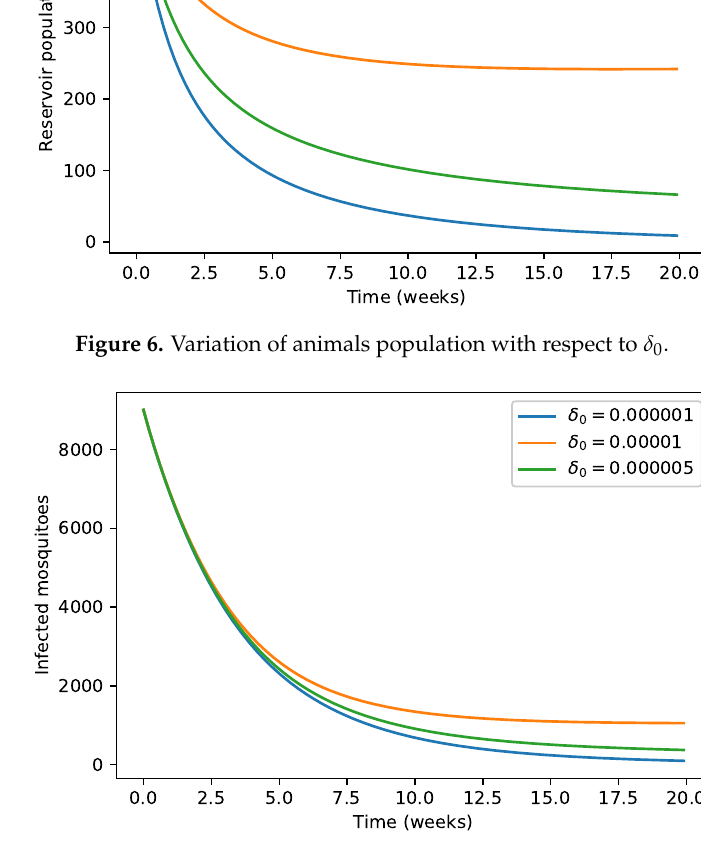
Figure 7. Variation of infected mosquitoes population with respect to δ 0